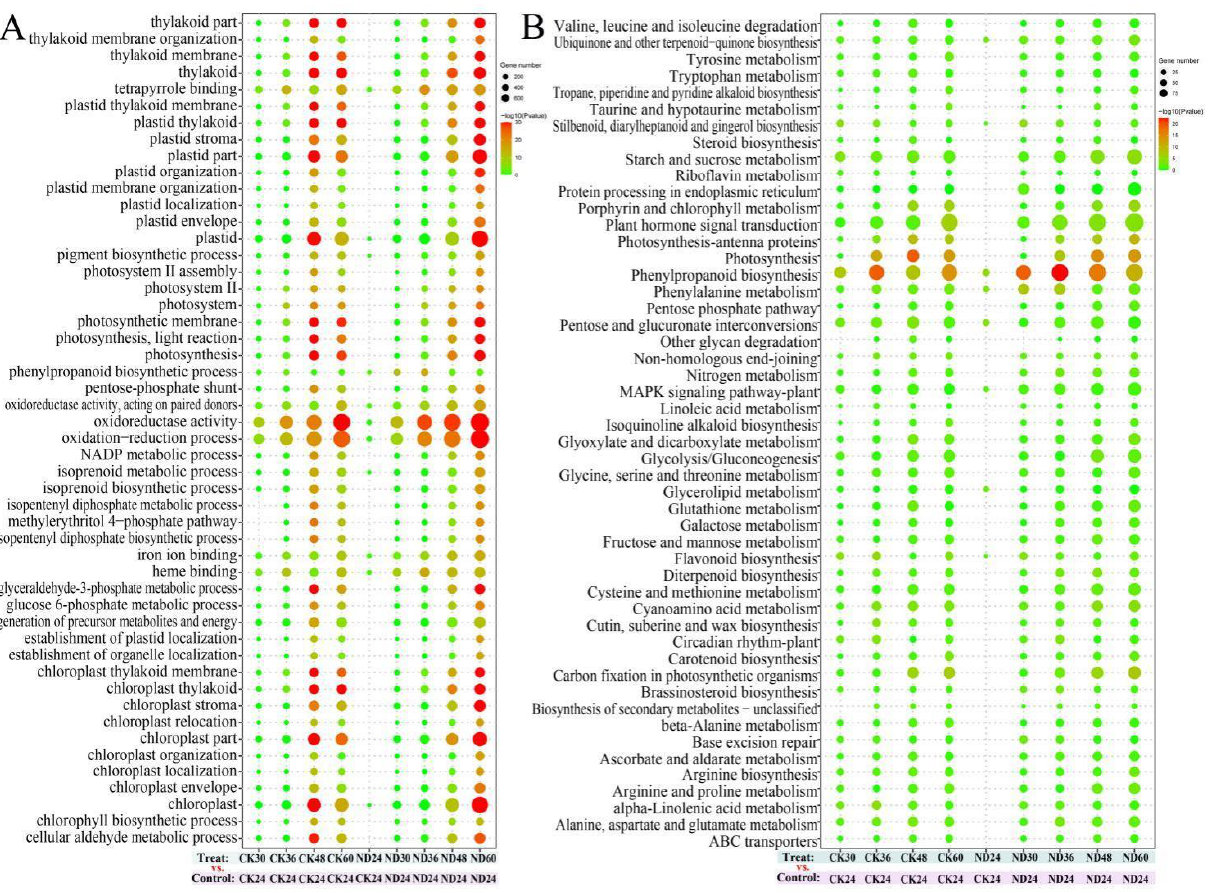
Figure 4. GO and KEGG enrichment analysis in responding to the infection and colonization of C. globosum strain ND35 in cucumber radicle. ( A ): Gene Ontology (GO) enrichment analysis; ( B ): Kyoto Encyclopedia of Genes and Genomes (KEGG) enrichment analysis. DEGs were classified into specific biological process categories and pathway categories with high classification stringency ( p < 0.05). The circle size represents the number of genes in the category. The circle color represents the significance probability, red represents higher significance levels, green represents lower significance levels.